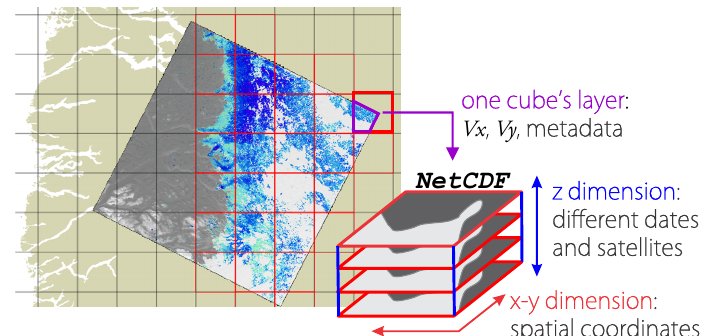
Figure 2. The schema of the cubes storage approach. On the left part: A preview of the speed map derived from the Landsat-8 18 September 2018 (master image) and 2 September 2018 (slave image) superposed on the outline of Greenland drawn with olive color. The black squares represent the entire regional cube grid; red squares are used to store the data from that particular image. On the Landsat image green and blue correspond to the successful speed estimation; black and white correspond to the areas without derived speed due to the ice-free ground or algorithm failure. On the right part: one NetCDF file consists of many layers (z dimension) that all cover the same area and correspond to the ice speeds derived from different images dates and